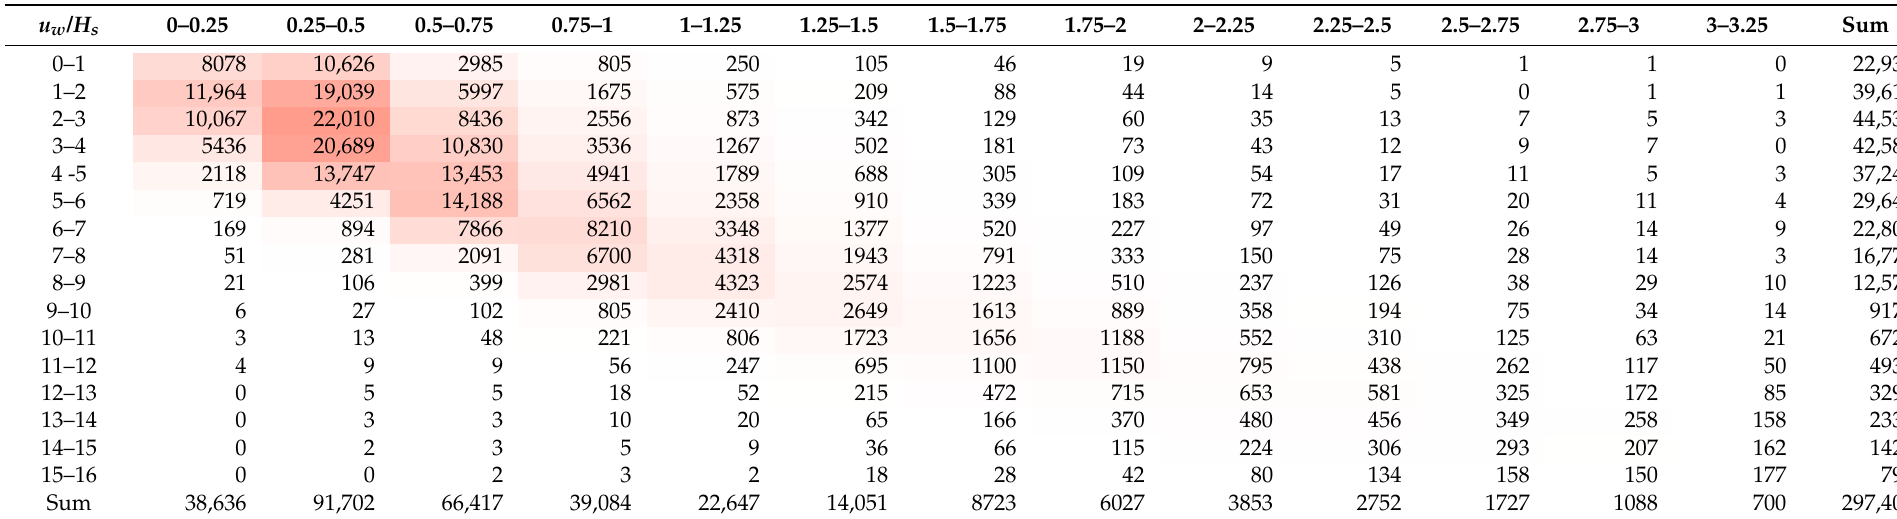
Table A7. Wind speed with significant wave height for North Adriatic region (locations 1–9).